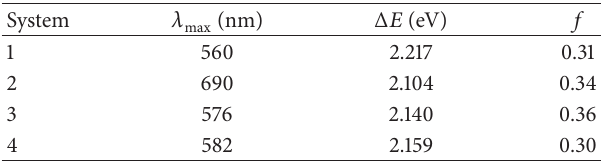
Table 3: Lowest absorption energy Δ𝐸 , maximum absorption 𝜆 and oscillating strength ( 𝑓 ).